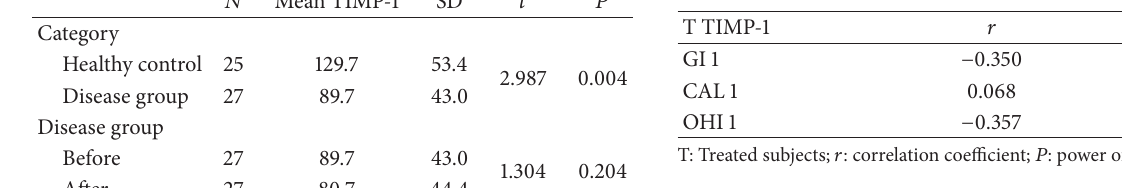
Mean MMP-8 value of 77.6±25.3 was seen in the healthy control group and 94.3 ± 32.5 in the periodontally